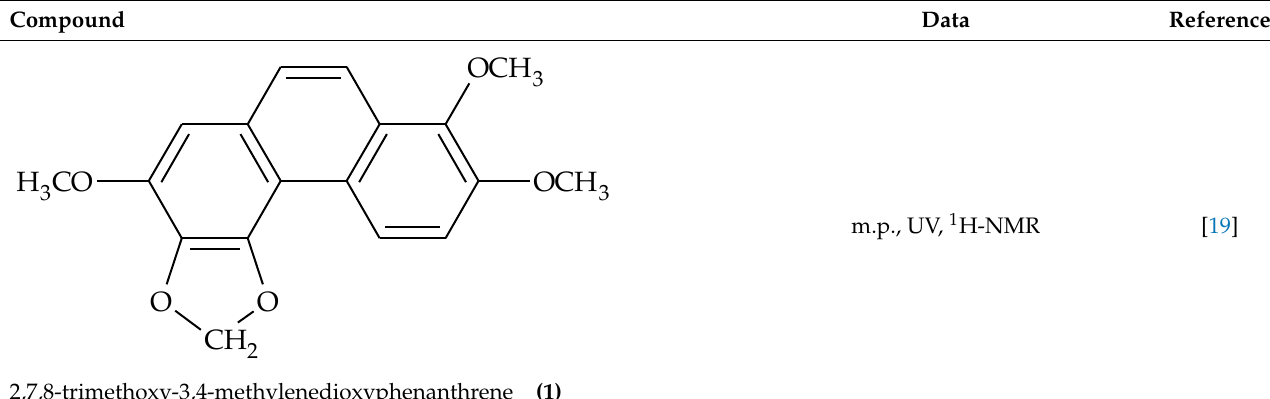
Table 1. Compounds isolated from organic extracts of Tamus communis rhizome.